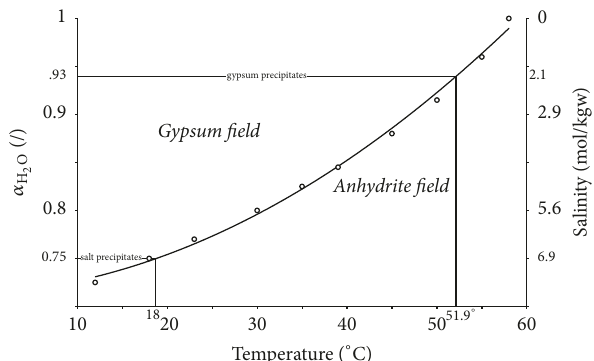
Figure 5: Gypsum and anhydrite stability fields depending on temperature and water activity (salinity) of the fluids involved (modified after Jowett et al. [32] with data from [Hardie [36]]).